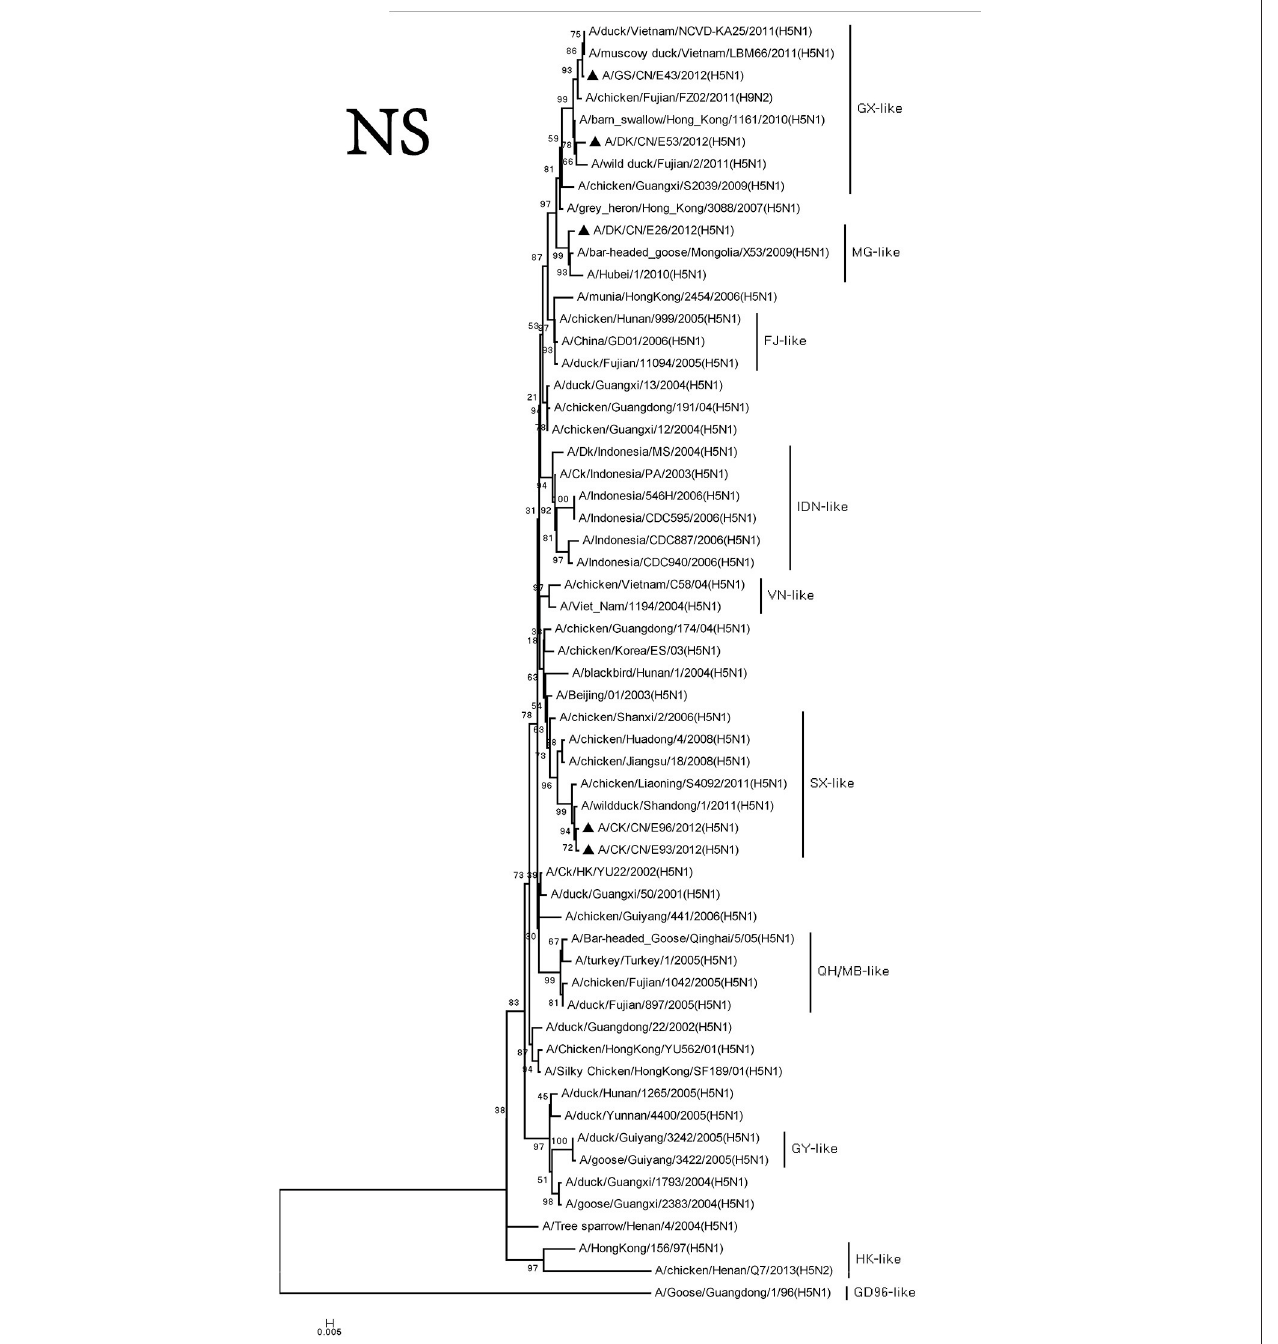
FIGURE 8 | Phylogenetic analysis of NS. NS: nt27–678. Except our isolate, other virus sequences were downloaded from GenBank. QH, Qinghai; VN, Vietnam; IDN, Indonesia; GY, Guiyang; MG, Mongolia; GX, Guangxi; HD, Huadong; SX, Shanxi.